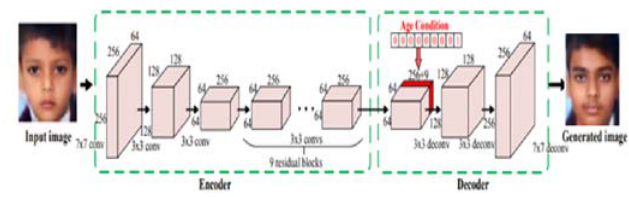
Figure 1. Layers used in Aging cGAN